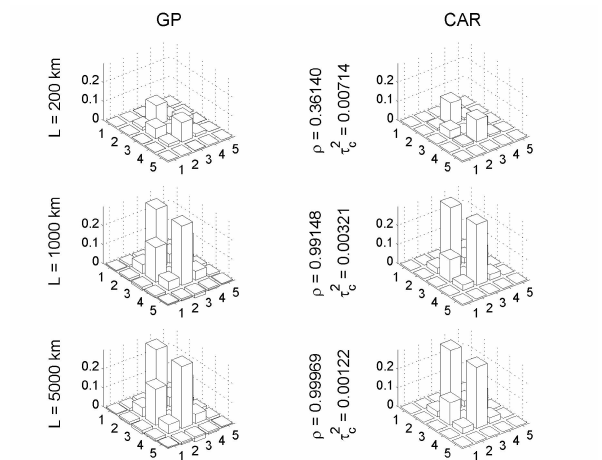
Fig. 1. Left: conditional regression coefficients from Gaussian process models (GP) with exponential decay correlation kernel exp ( − d/L) for several values of the range length L . Here d is the centroid-centroid distance between cells and the regression co- efficients plotted are those for the regression of the central cell (3,3) on the rest. The mesh size is not constant over the entire lattice; assuming the mean radius of the Earth to be 6371km, the average size of a 4 ◦ latitude × 5 ◦ longitude cell is 445km × 556km. Right: conditional regression coefficients from CAR model using ρ values fitted to match the regressions in the corresponding GP